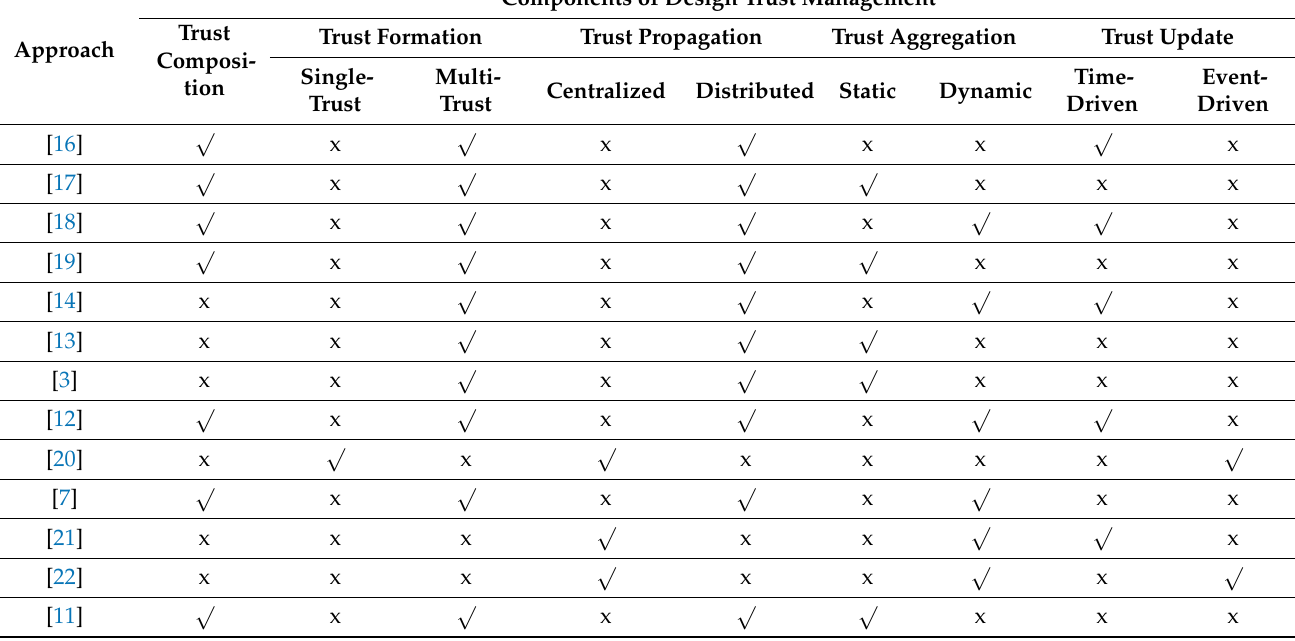
Table 1. Summary of existing